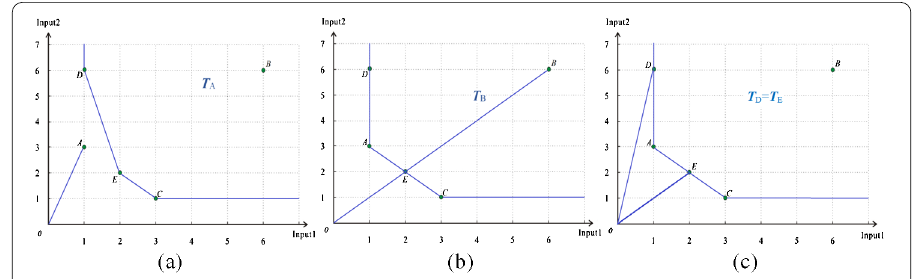
Figure 2 Efficiency analysis of DMUs A , B , D and E